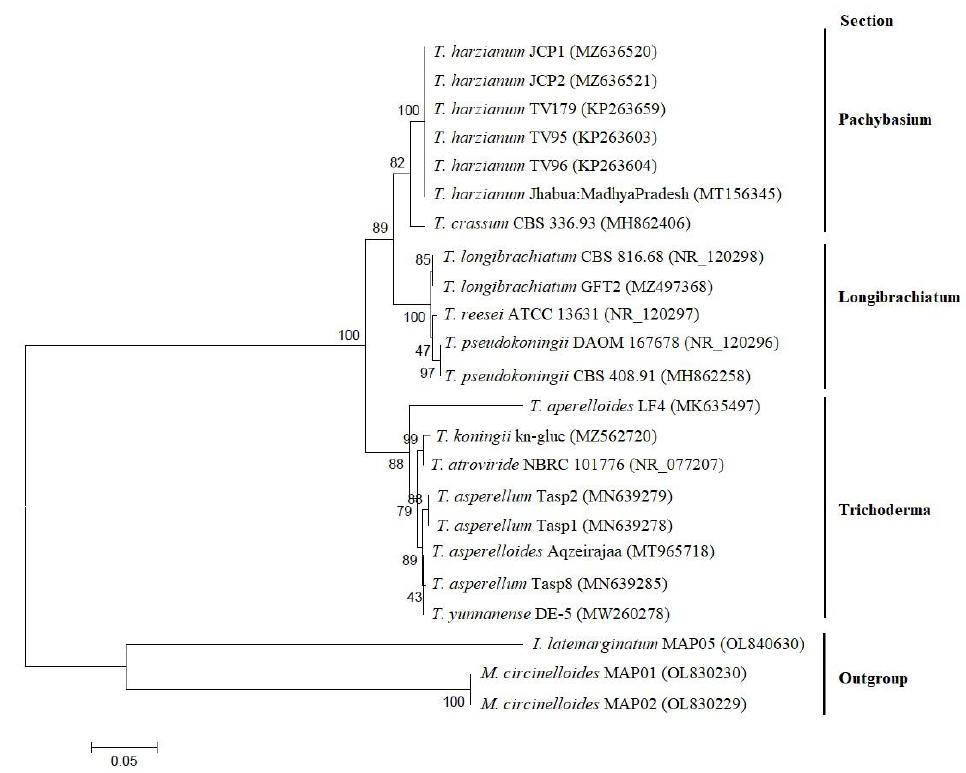
Figure 2. Phylogenetic tree for Trichoderma strains JCP1 and JCP2, generated with the Neighbor- joining method, obtained by analyzing the Jukes–Cantor model based on ITS sequence data of Trichoderma species from NCBI GenBank. Adjacent numbers in nodes are bootstrap values and ac- cession numbers are indicated in parentheses.